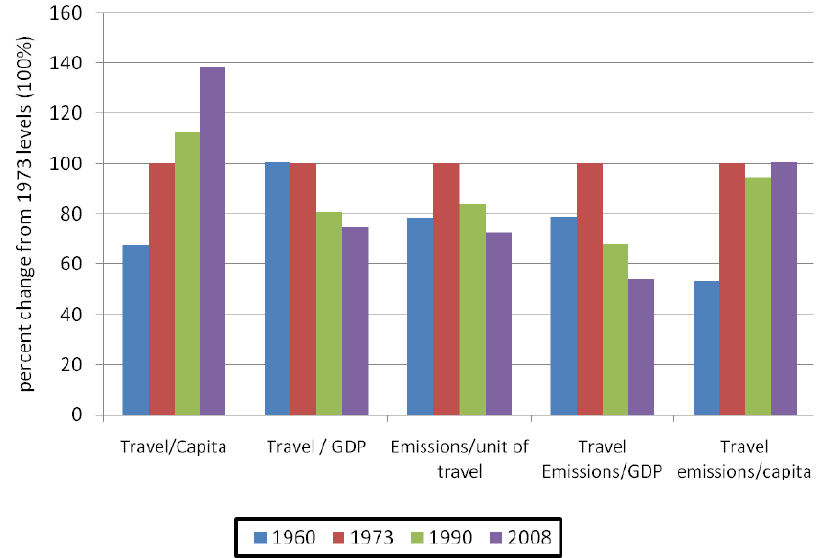
Figure 5. Summary of Emissions Changes from Passenger Travel.